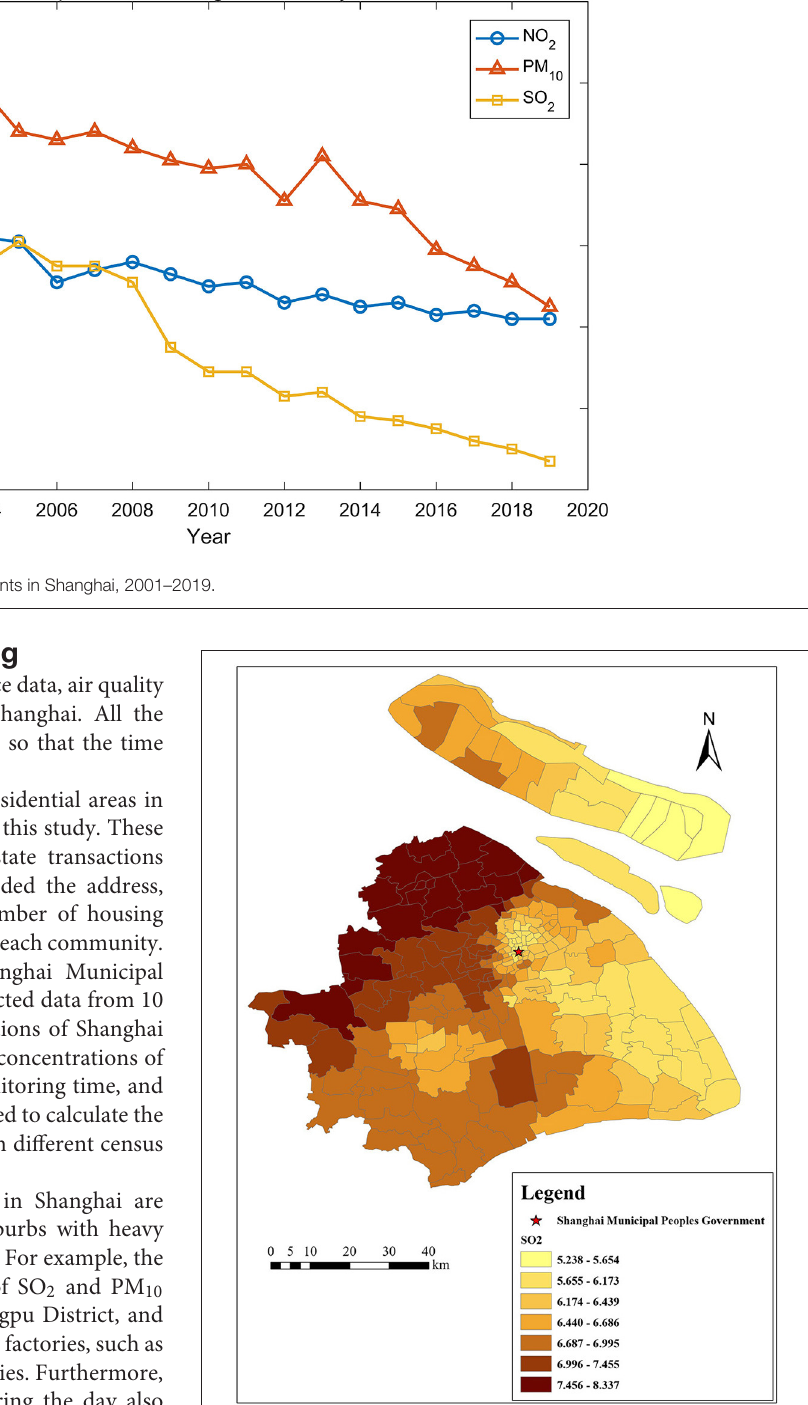
environmental data were composed of population data, urban road network data, and point of interest (POI) data.